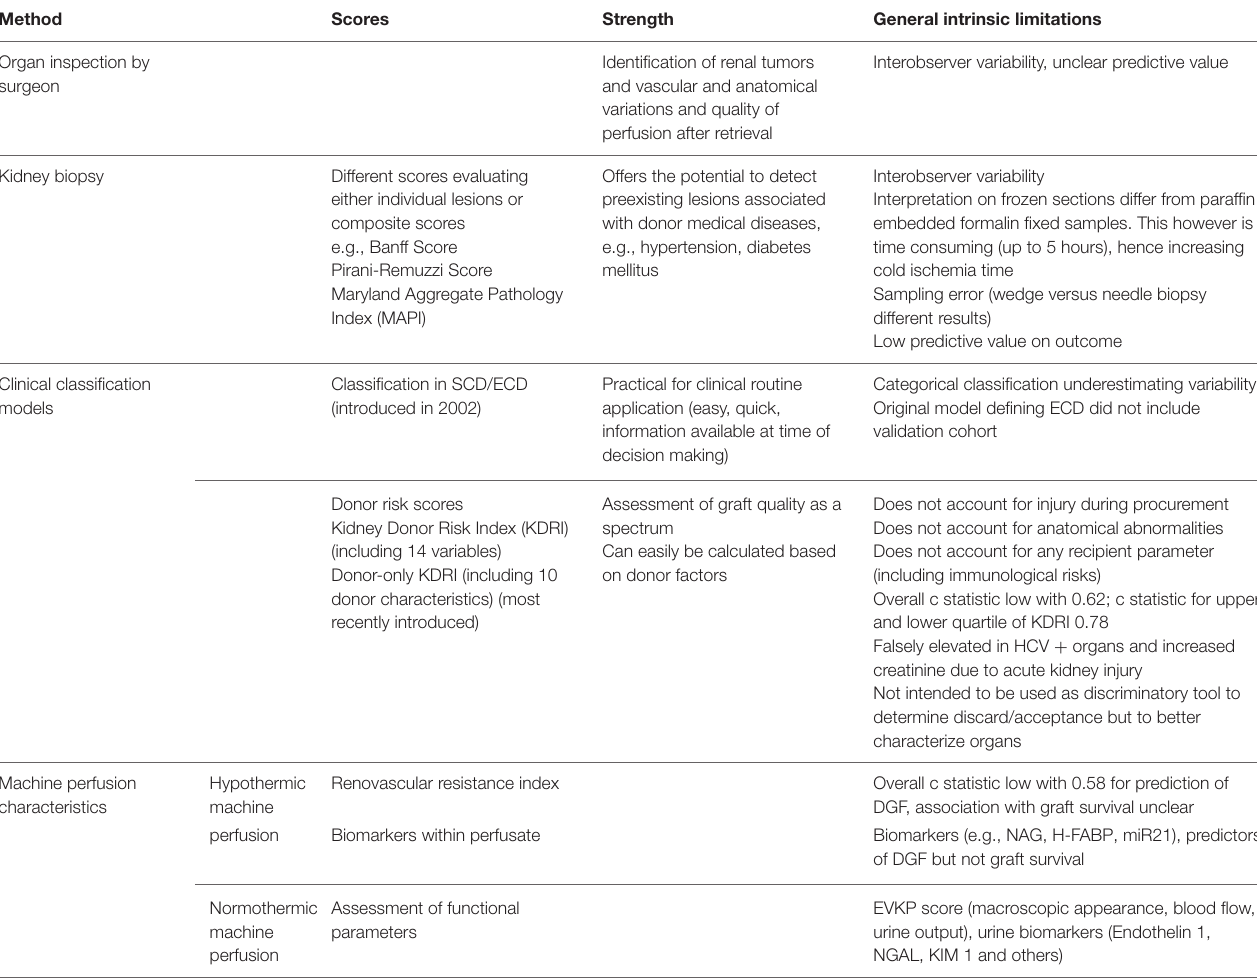
TABLE 1 | Comparison of different assessment tools to evaluate organ quality in kidney